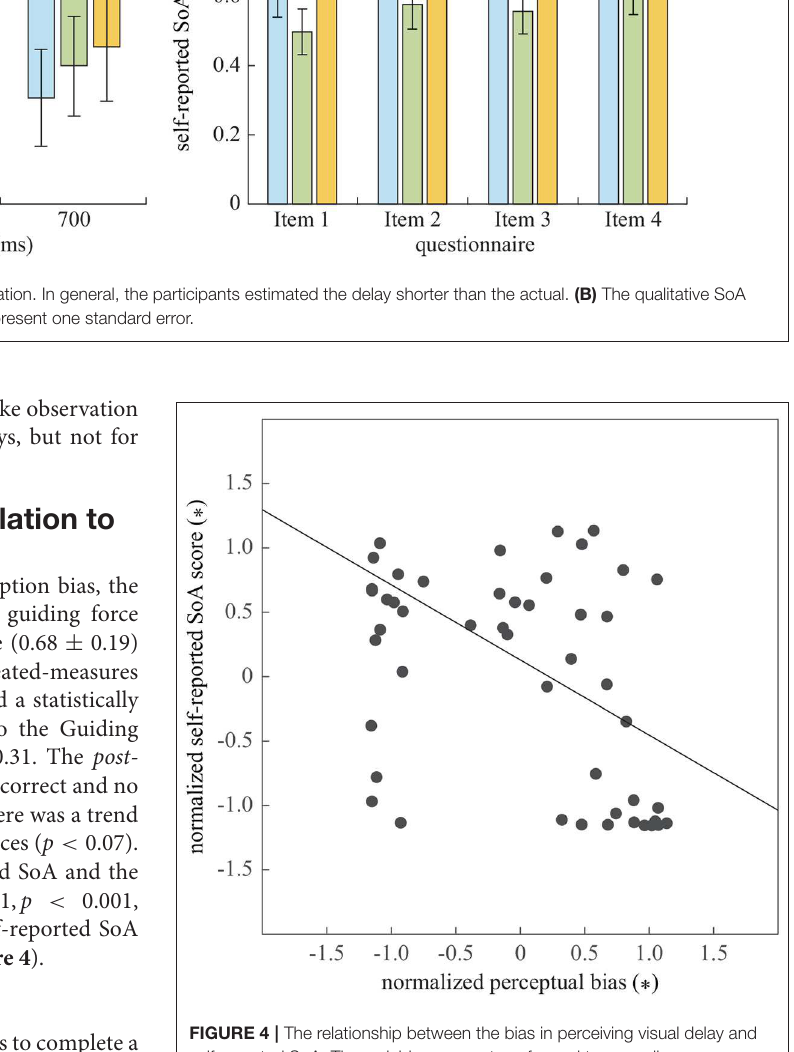
FIGURE 4 | The relationship between the bias in perceiving visual delay and self-reported SoA. The variables were z-transformed to normalize across participants. The line shows the linear